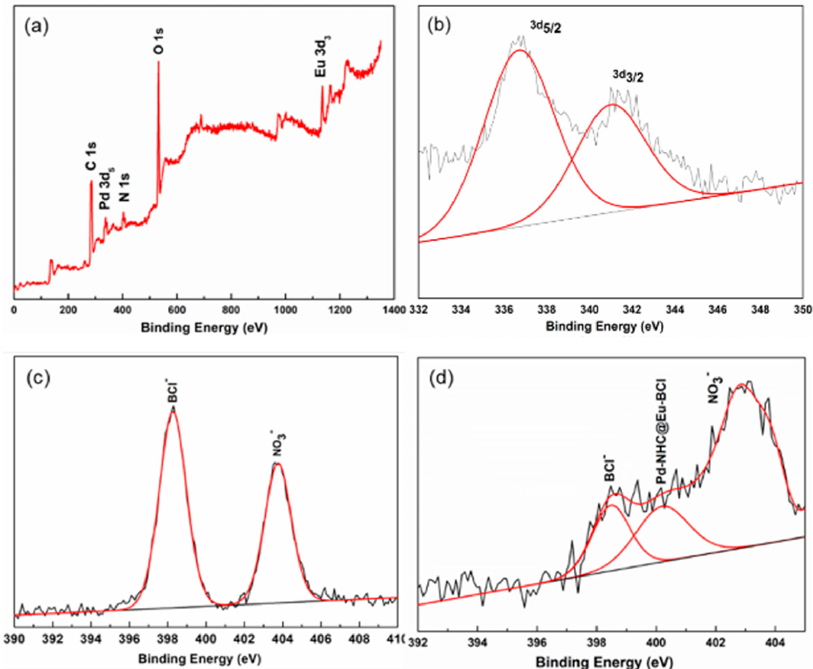
Figure 4. (a) XPS spectrum of Pd-NHC@Eu-BCI. (b) The Pd 3d XPS spectra of Pd-NHC@Eu-BCI. (c) Figure 4. ( a ) XPS spectrum of Pd-NHC@Eu-BCI. ( b ) The Pd 3d XPS spectra of Pd-NHC@Eu-BCI. The N 1s spectra of Eu-BCI. (d) The N 1s spectra of Pd-NHC@Eu-BCI. ( c ) The N 1s spectra of Eu-BCI. ( d ) The N 1s spectra of